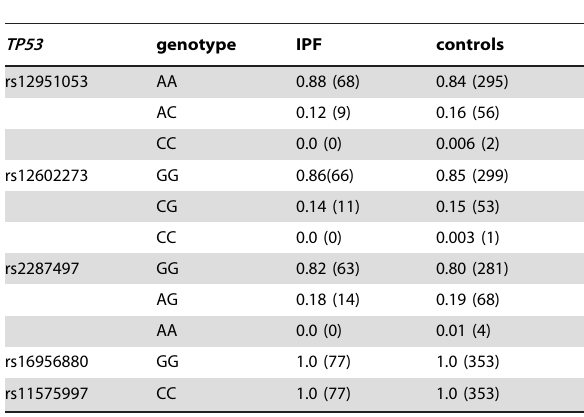
Table 1. TP53 genotype frequency in patients and